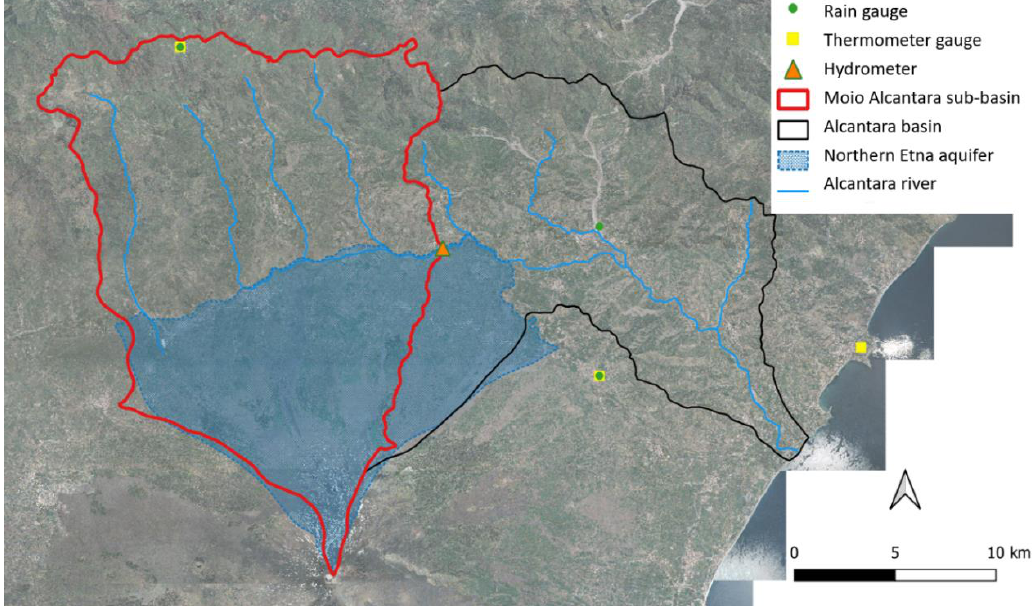
Figure 1. Moio Alcantara sub-basin (in red) and the Northern Etna groundwater aquifer (in light blue). Table 1. Main characteristics of the Alcantara Basin and Moio Alcantara sub-basin Characteristic Alcantara Basin Moio Alcantara Sub-Basin Area (km 2 ) 603 342 Mean elevation (m a.s.l.) 531 1142 Max elevation (m a.s.l.) 3274 3274 Min elevation (m a.s.l.) 0 510 Main river length (km) 54.67 34.66 Medium river slope 0.059 0.080 Mean annual rainfall (mm) 880 874 Mean annual runoff (mm) 342 222 Mean annual runoff coefficient 0.39 Permeable area (%) 43 46